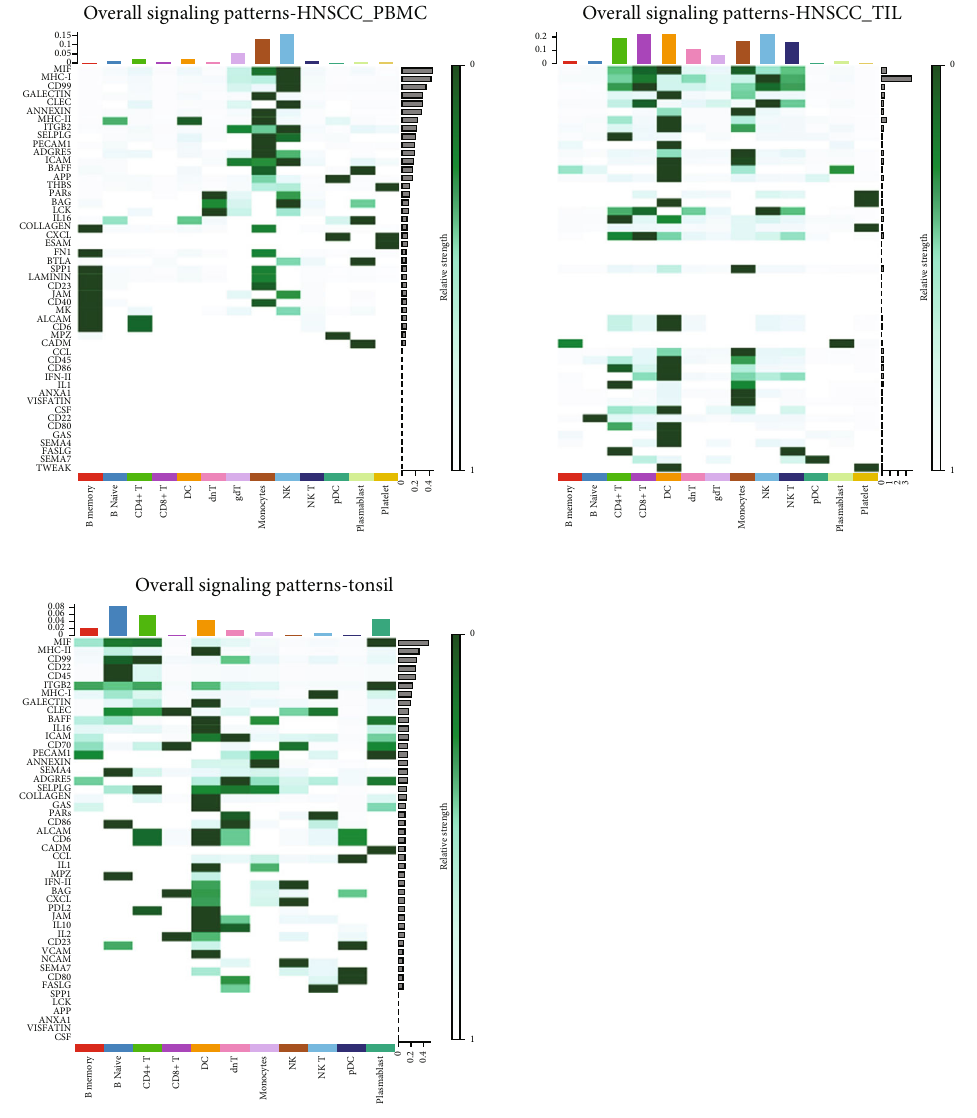
Figure 3: Cell-Cell interaction comparison in di ff erent types. (a) Overview on the di ff erent interactions in HNSCC-TIL, HNSCC-PBMC, normal tonsil, and healthy PBMC. Left side is the interaction number, and right side represents interaction strength. (b) Visually integrated cellular communication network. Circle chart showing the interaction between any two cell groups. (c) Overall signal patterns in di ff erent cells derived from HNSCC-PBMC, HNSCC-TIL, and tonsil in the heatmap; the vertical axis is the cell that sends or receives the signal, and the horizontal axis is the pathway that receives or sends the signal. The color of the heat map represents the strength of the signal. The pillars on the upper and right sides are the accumulation of the strength of the vertical axis and the horizontal